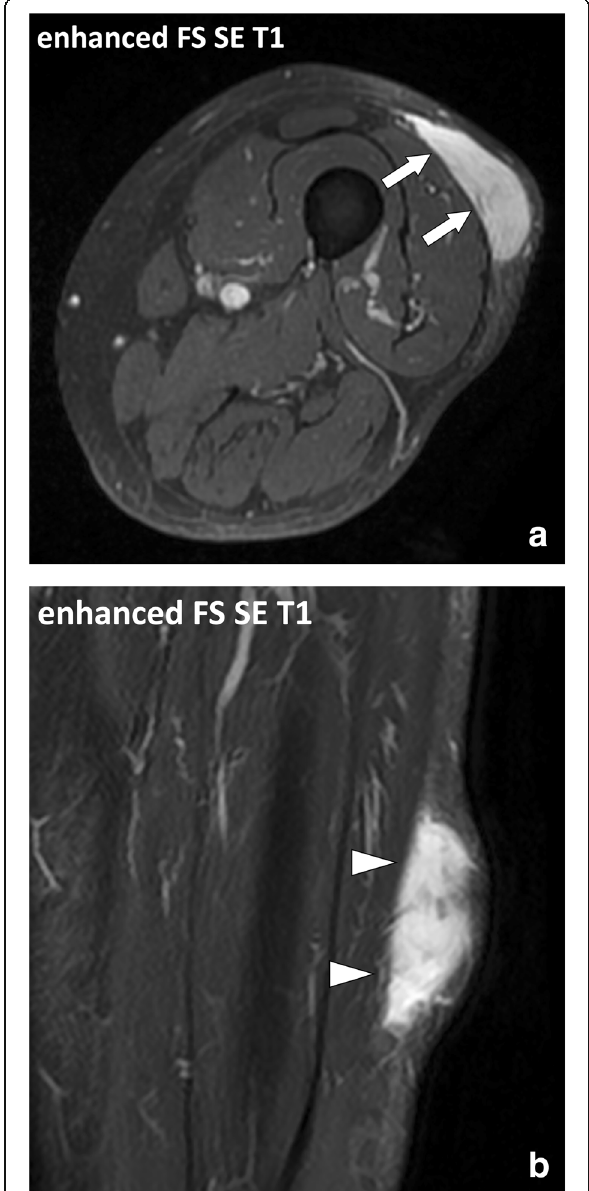
Fig. 16 Focused ( a ) axial, i.e., short axis, and ( b ) coronal, i.e., long axis, SE T1w contrast-enhanced fat-suppressed images of the left thigh of a 75-year-old male with high-grade myxofibrosarcoma. Axial images clearly demonstrate the localization of the lesion in the hypodermis and its anatomical relationship with the underlying deep peripheral fascia (arrows). The deep fascia is less conspicuous on the longitudinal images due to partial volumes